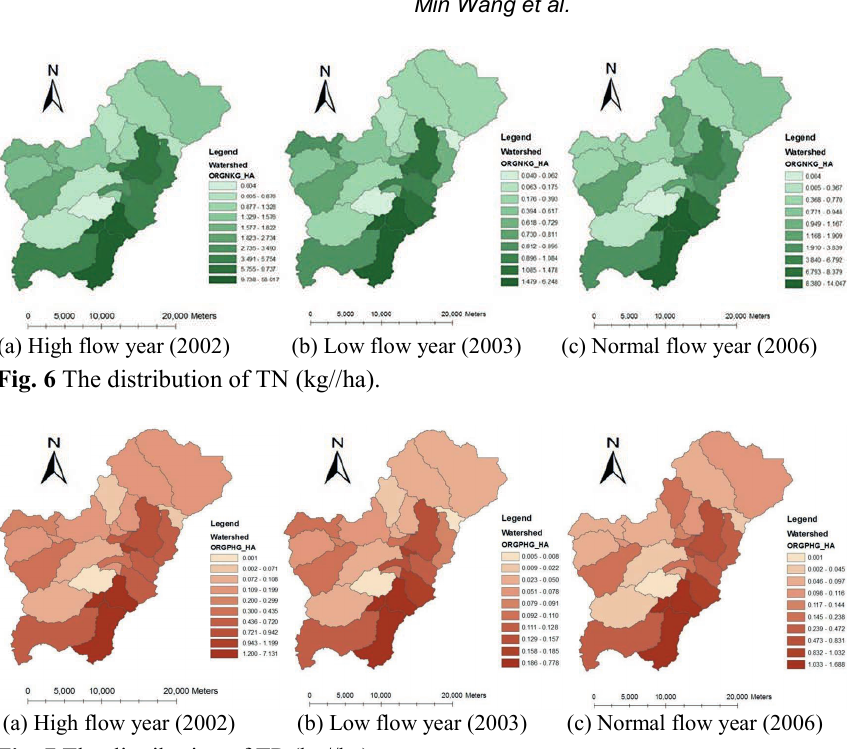
Fig. 7 The distribution of TP